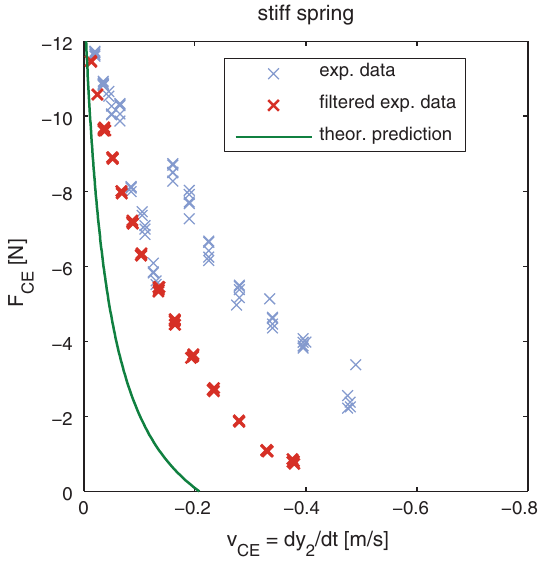
Fig. 6. Comparison of raw experimental data (faint blue x’s) filtered experimental data (dark red x’s) and theoretical prediction (green line). The experimental force and velocity data was filtered with (cid:2) a 4th order Butterworth low-pass filter at a cutoff frequency f = k/m . (Colours are visible in the online version of the article; 1 2 π